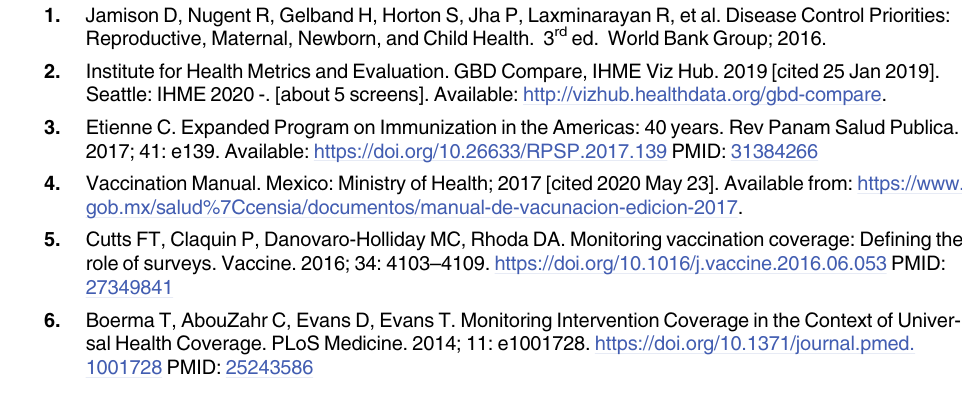
S2 Table. Estimated vaccination coverage of “with vaccination card” and “without vaccina- tion card” groups by year and age groups, Mexico 2000–2018. BCG, Bacillus Calmette-Gue- rin vaccine; PV, complete cells pentavalent vaccine; PVa, acellular pentavalent vaccine; HB, Vaccine against Hepatitis B; Pnm, Conjugate vaccine against Pneumococcal; RV, Vaccine against rotavirus; MMR, Vaccine against measles, mumps, and